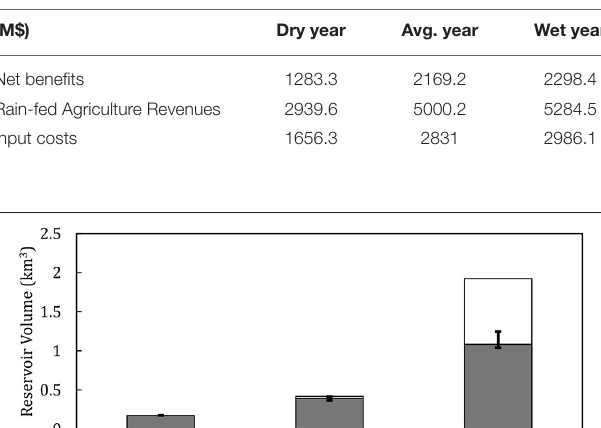
TABLE 3 | The maximized net benefits from rain-fed agriculture, the crops revenues, and the input costs for the dry, average, and wet years.